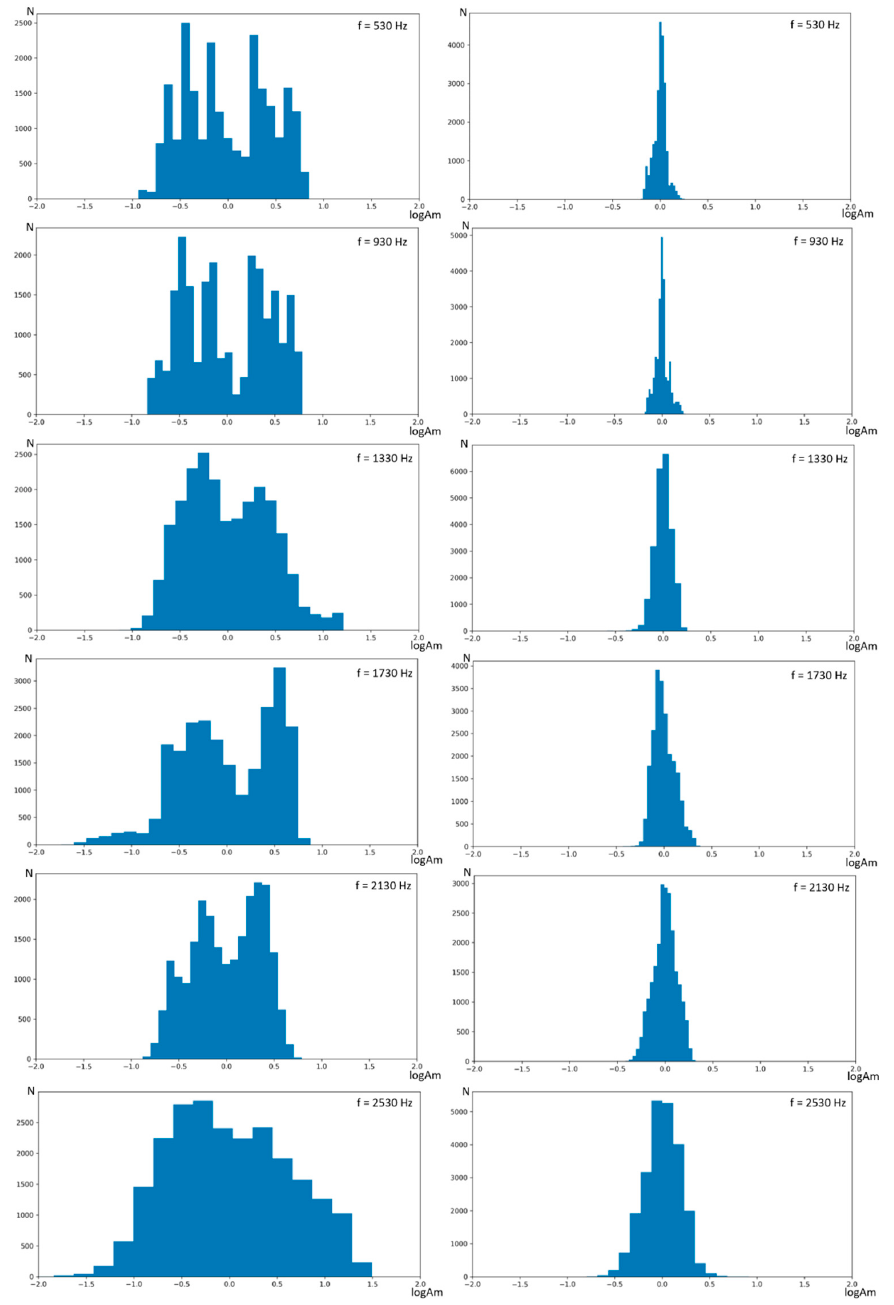
Figure 9. Histograms are plotted in the log ‐ spectral region for six frequencies (frequency values are given in the figures, and explanations in the text). The left column shows histograms of spectra before factor decomposition. The right column shows histograms of spectra after factor decomposition.